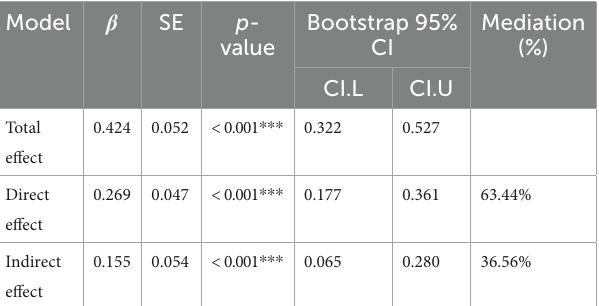
TABLE 4 Mediating effect analysis.